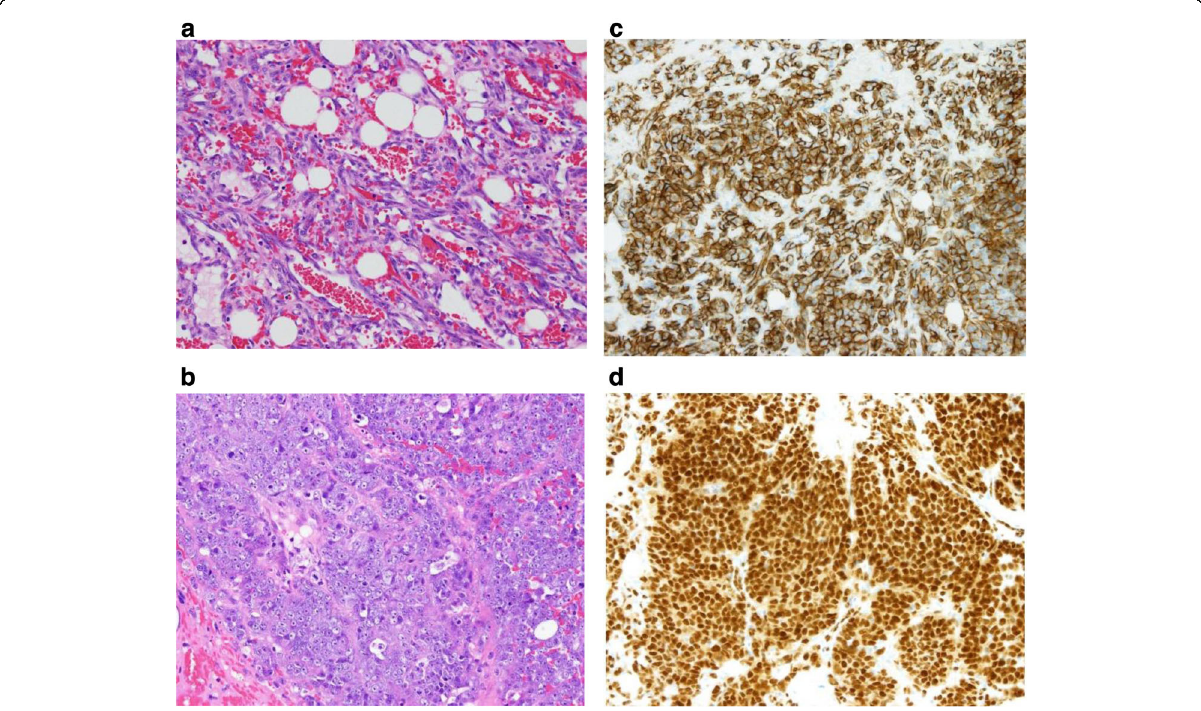
Fig. 6 a Pathological analysis of the mastectomy revealed atypical cells that formed vascular spaces. (H-E) b Atypical cells proliferated. The cellularity of the block was very high. (H-E) c The endothelial cells showed strong positive staining with antibodies against CD31. d The nucleus showed strong positive staining with antibodies against